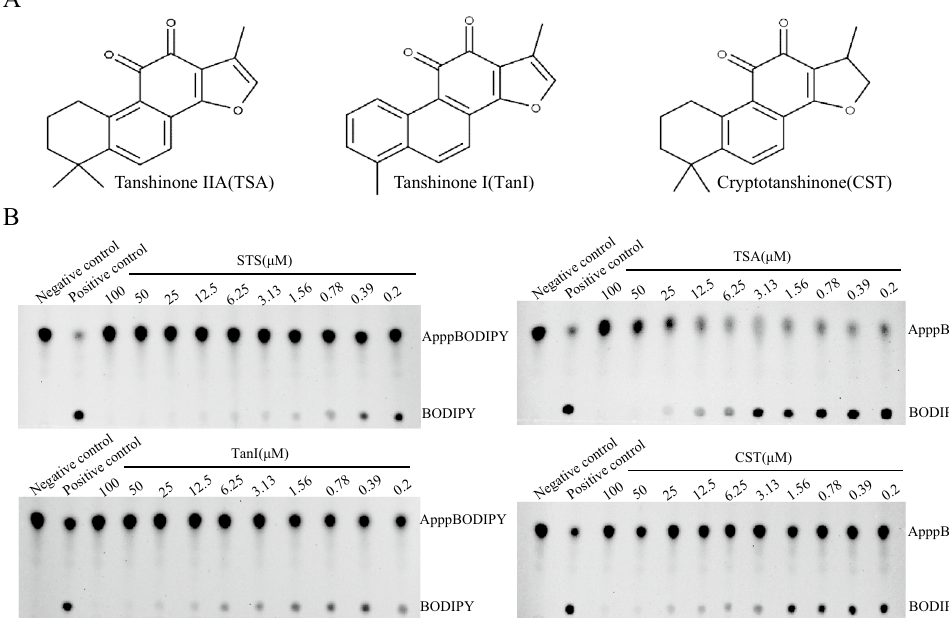
Figure 5. Tanshinone compounds inhibit FHIT Ap3A hydrolase activity. ( A ) Chemical structure of Tanshinone IIA (left), Tanshinone I (middle), and Cryptotanshinone (right). ( B ) Fluorescent thin layer enzyme assay, significant inhibition activity was detected in all the tanshinone compounds with IC50 value at ~ 5